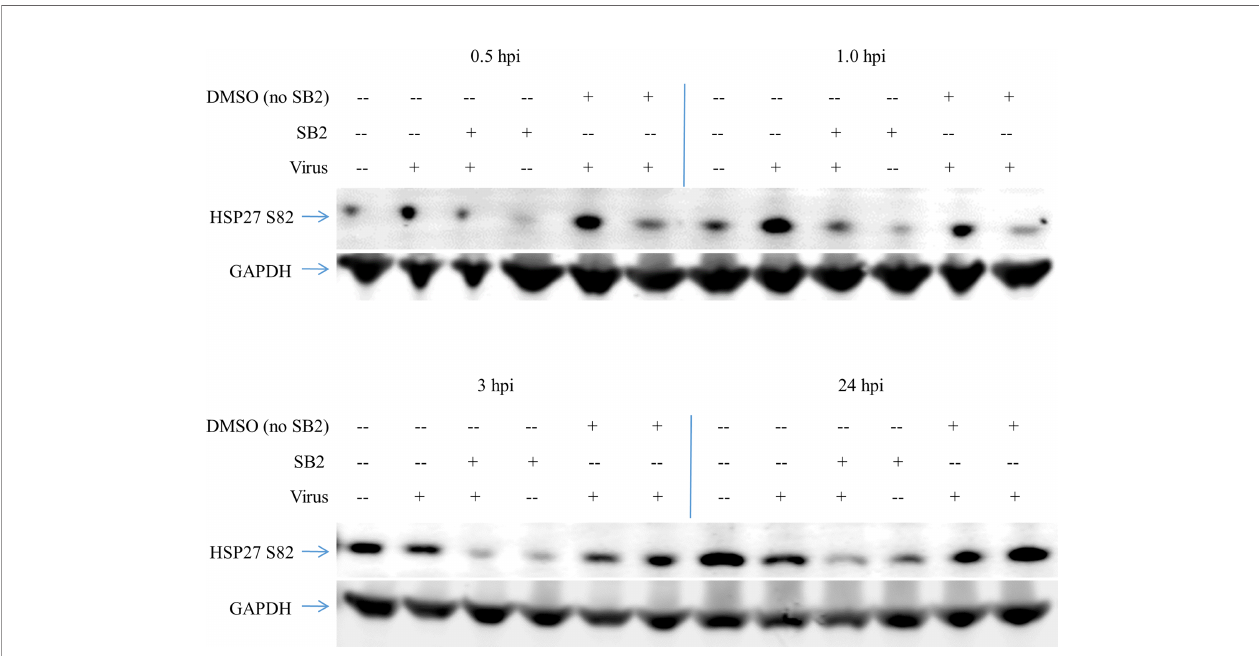
FIGURE 3 | HSP27 phosphorylation upon JUNV infection results from p38 MAPK activity. HSAEC cells were pretreated with 40 nM SB 203580, or the equivalent concentration of DMSO, or media alone for 2 h, then infected with CD1 or mock infected in duplicate. At 0.5 – 24 h the cells were lysed, and then the duplicates were pooled and probed for HSP27 S82 and GAPDH by Western blot. One representative of two experiments is